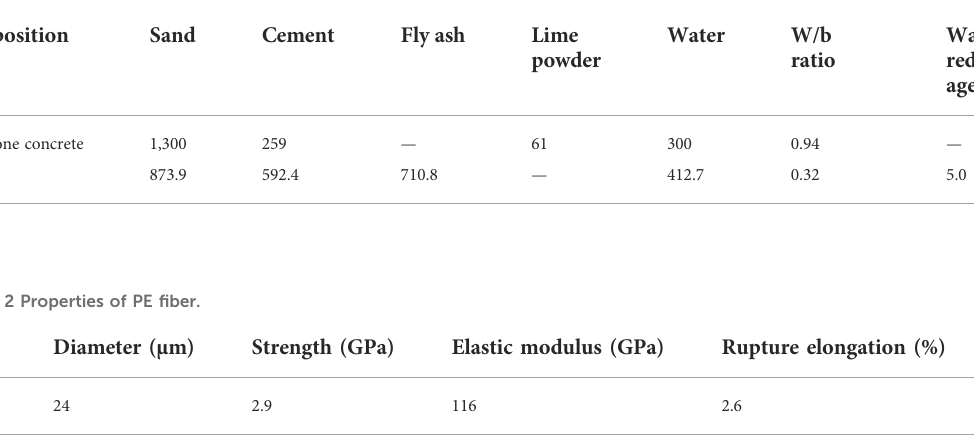
TABLE 1 ECC material mixing proportion (kg/m 3 ).